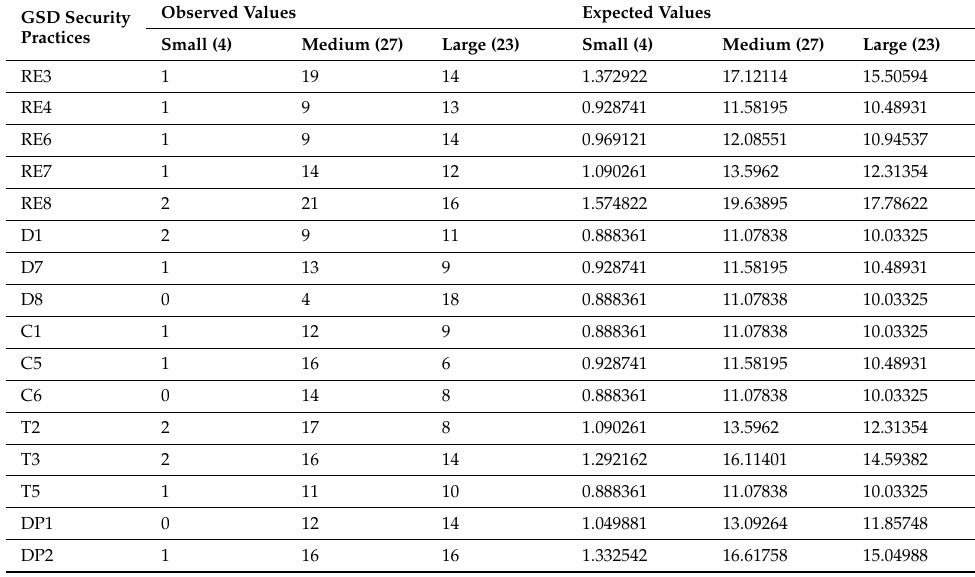
Table 4. Observed and expected values of selected GSD security practices by practitioners from varying size GSD